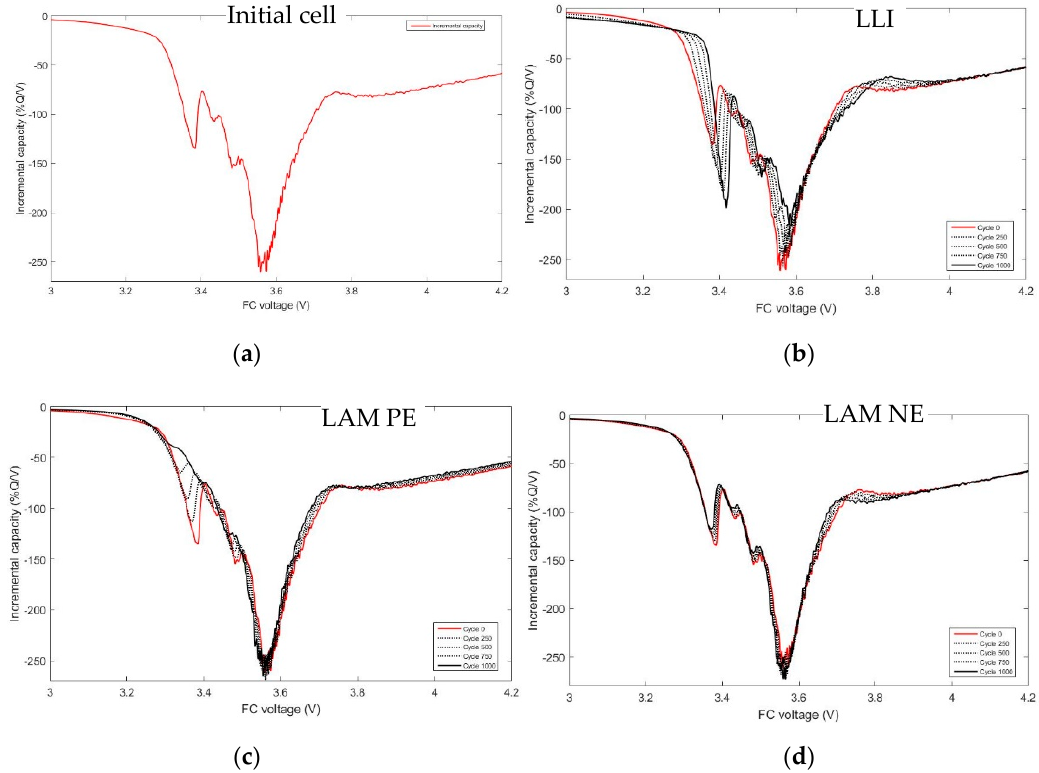
Figure 9. IC curves obtained from the ‘alawa’ toolbox: ( a ) Initial cell, ( b ) lithium inventory (LLI), ( c ) LAM PE, and ( d ) LAM NE. The red curve is the initial curve, and the other curves show the tendency of evolution every 250 cycles.